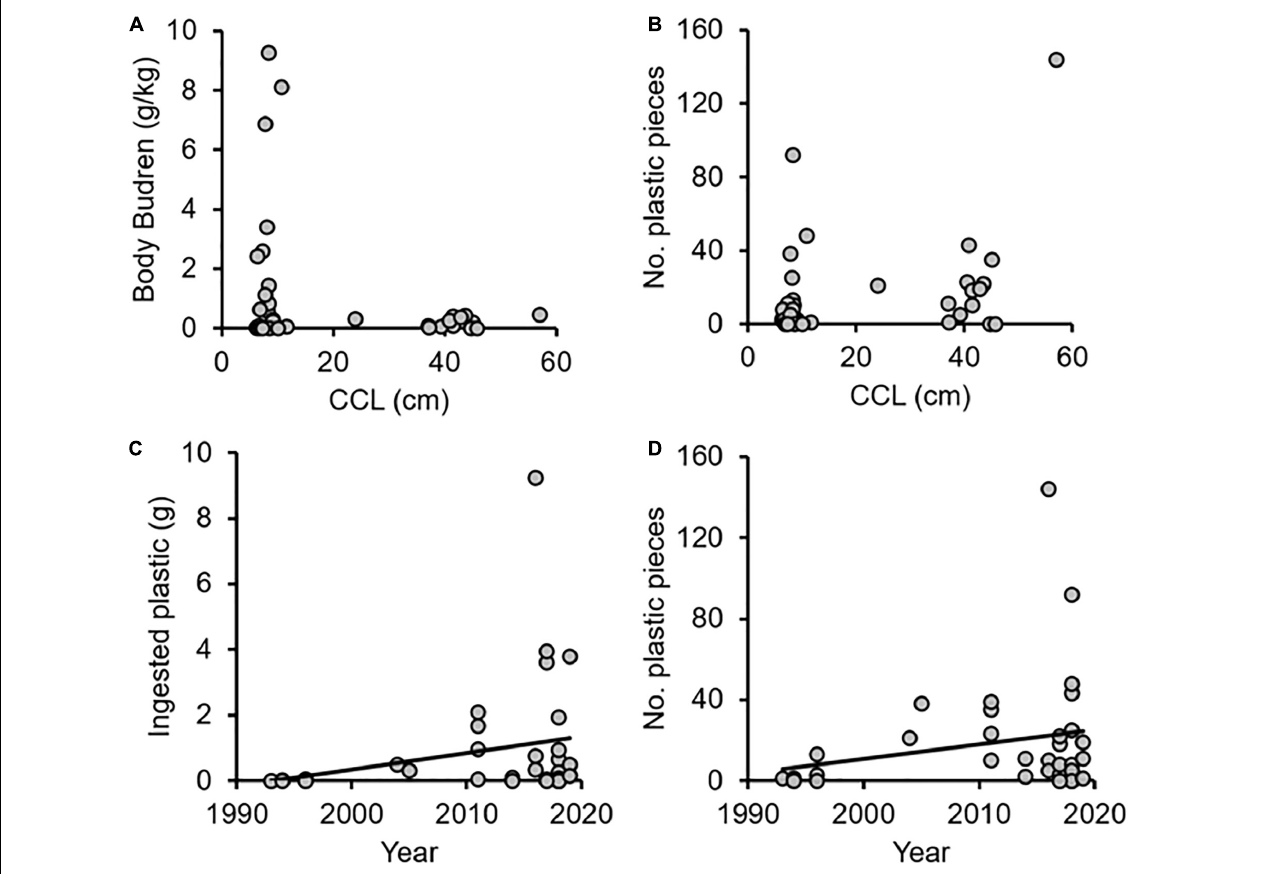
FIGURE 2 | Turtle length and temporal incidence of plastic in green turtle ( Chelonia mydas ) post-hatchlings in the Pacific ( n = 35). Relationship between curved carapace length and (A) plastic debris body burden index (mg plastic/g turtle) and (B) number of ingested pieces of plastic debris. Relationship between year of stranding and (C) mass of ingested plastic pieces (g) (D) number of ingested plastic pieces found at necropsy.